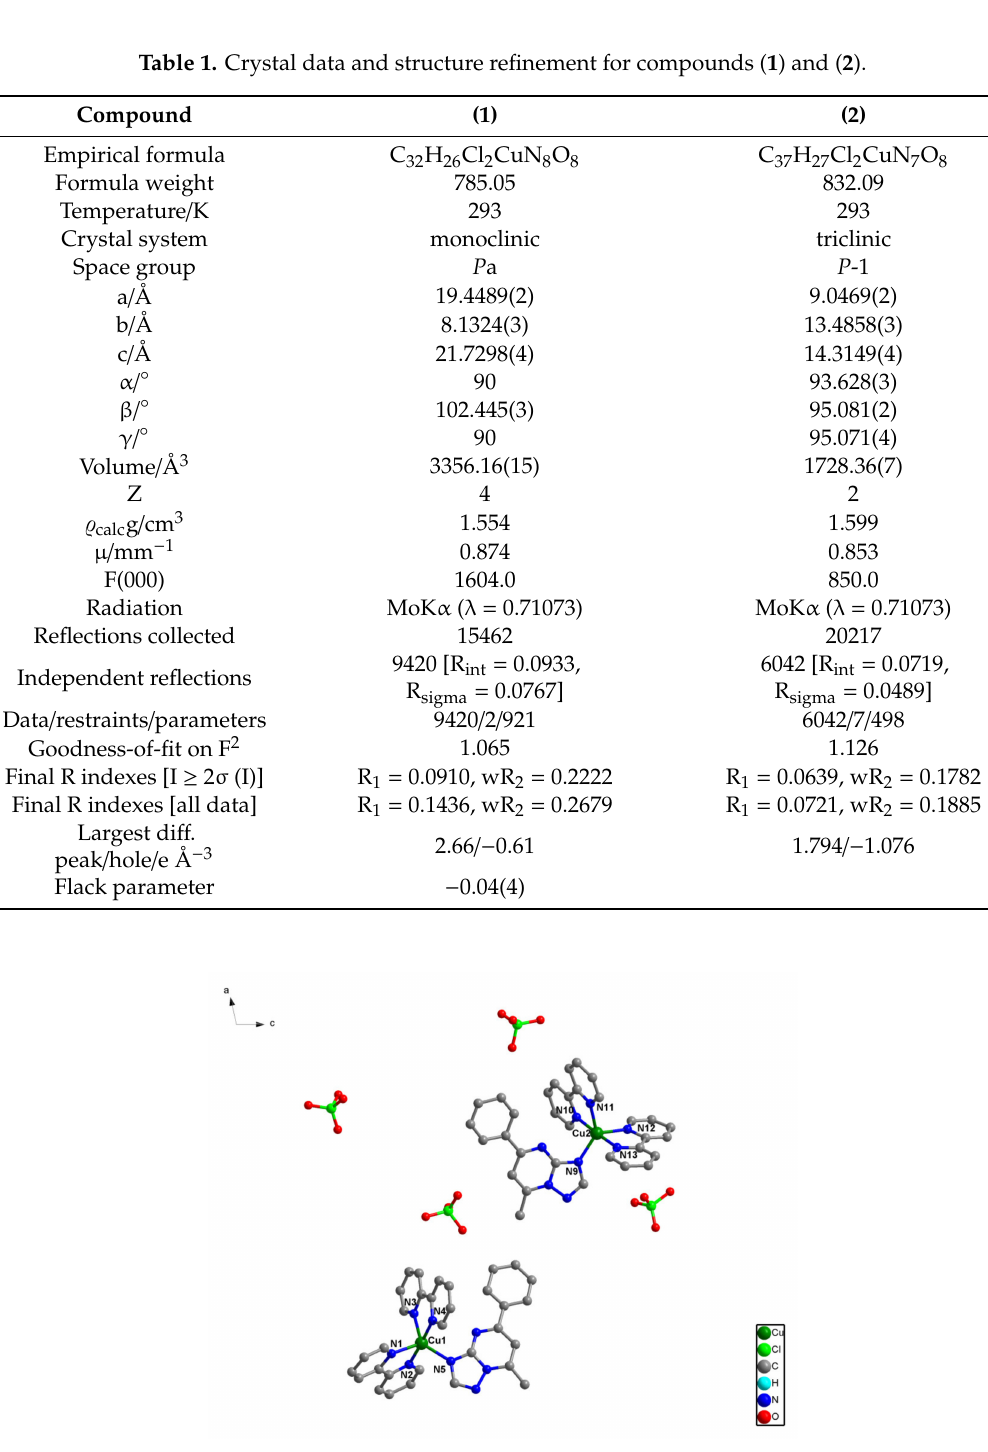
Figure 1. The asymmetric unit of two crystallographically non-equivalent mononuclear [Cu(bpy) 2 (pmtp)](ClO 4 ) 2 ( 1 ) complex along b